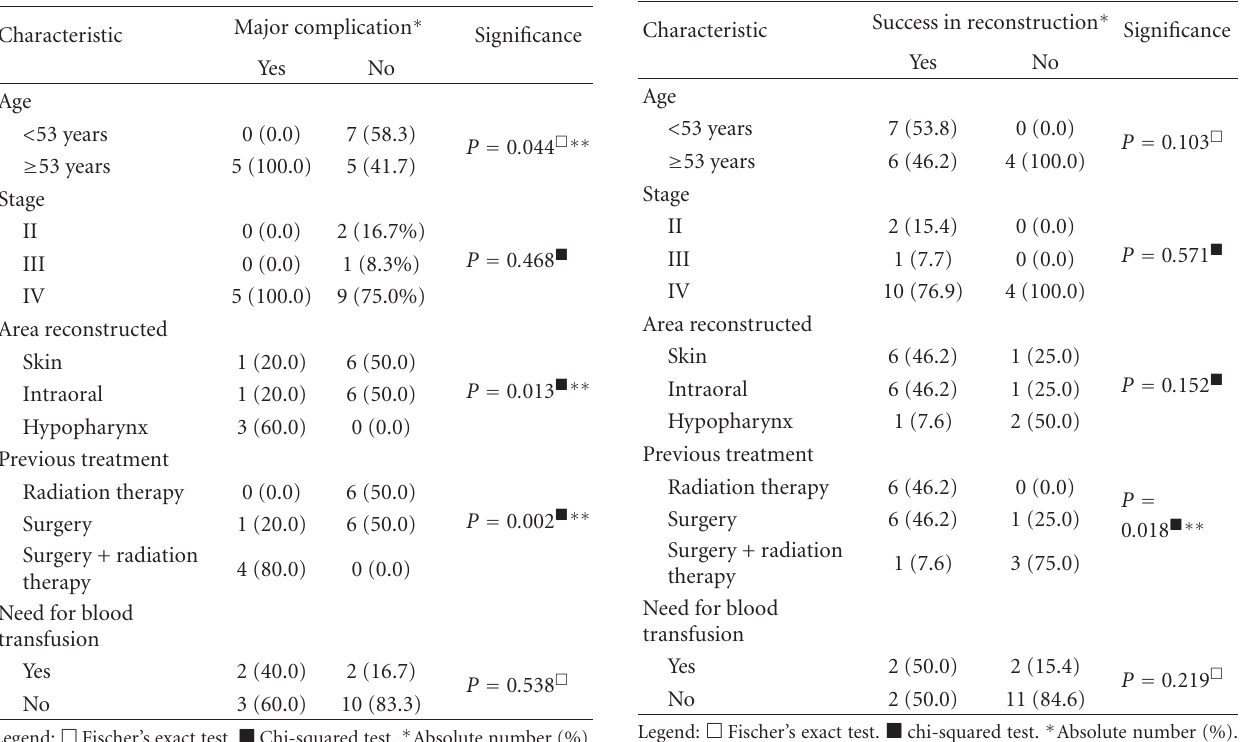
Table 3: Analysis of the variables determining major complications resulting from reconstruction.